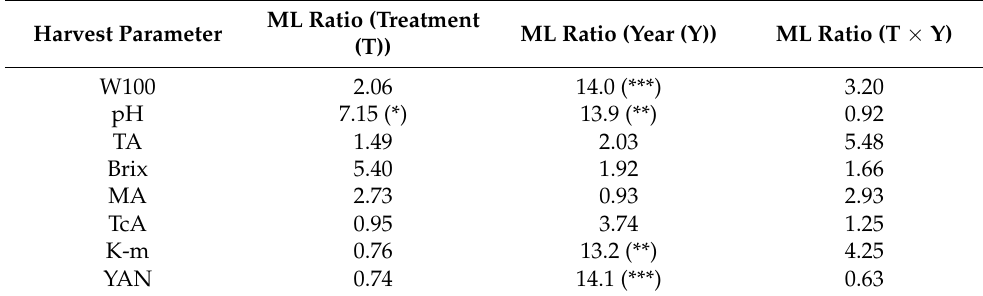
Table 5. Analysis of variance (ML: Maximum likelihood) performed on harvest parameters (weight of 100 grape berries (W100), real acidity (pH), titratable acidity (TA), Brix degrees (Brix), malic acid (MA), tartaric acid (TcA), must potassium levels (K-m) and yeast assimilable nitrogen (YAN)). The results were significant at * p < 0.05, ** p < 0.01 and *** p < 0.001.